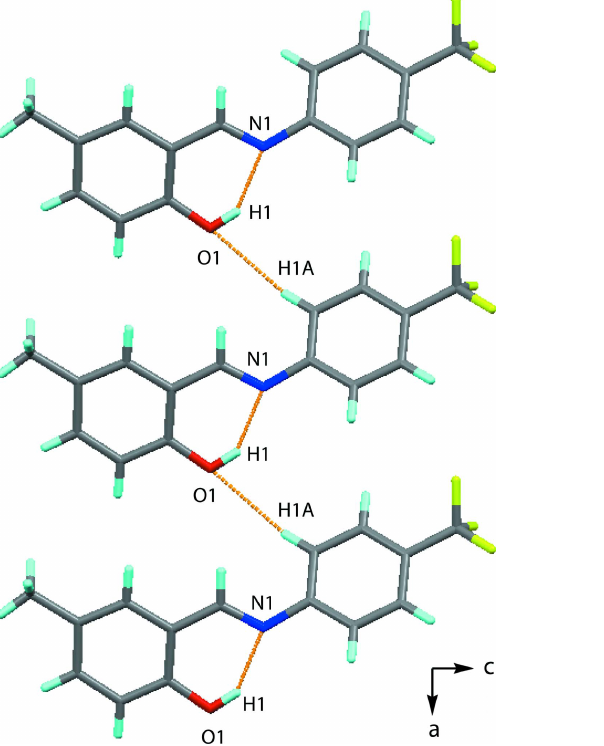
Figure 2 A view along the b axis of the polymeric chain formed via C—H (cid:2)(cid:2)(cid:2) O interactions (see Table 1 for details).